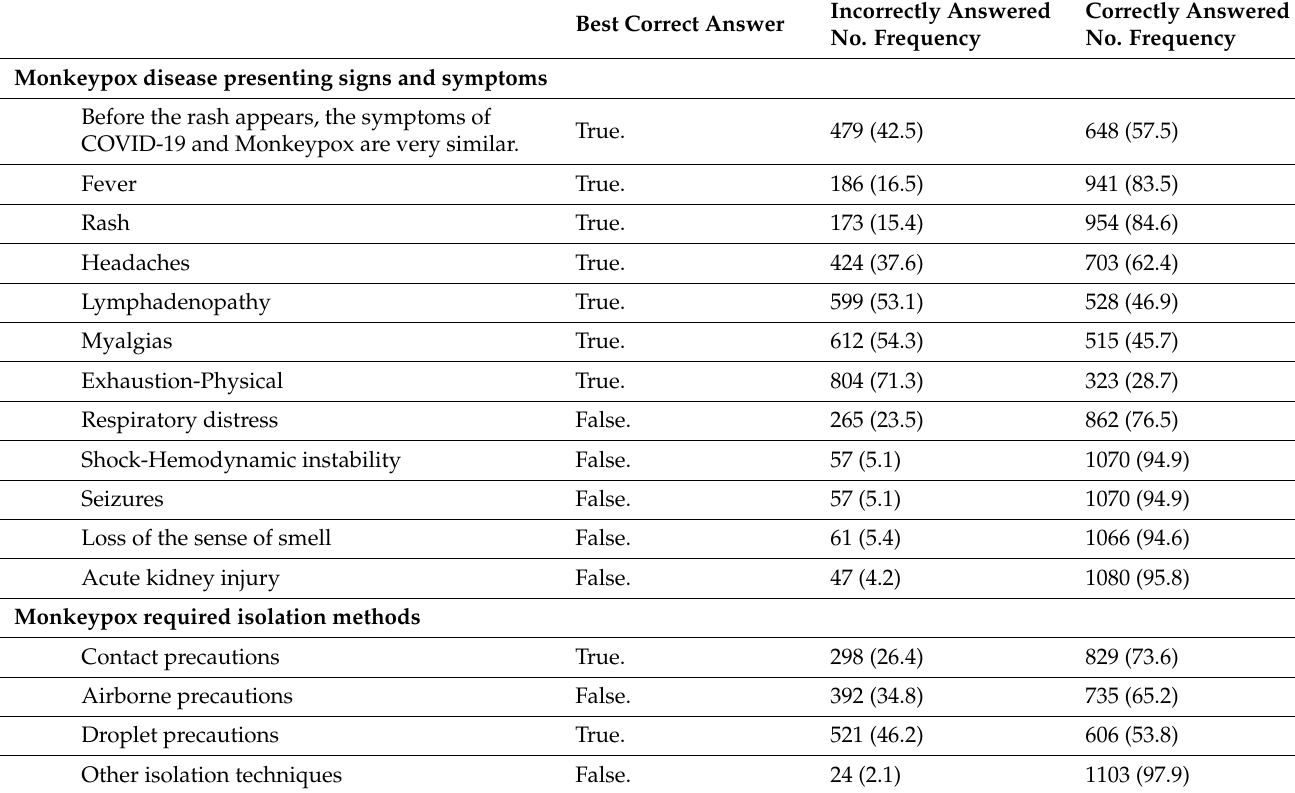
Table A2. Cont. Incorrectly Answered Correctly Answered Best Correct Answer No. Frequency No. Frequency Monkeypox disease presenting signs and symptoms Before the rash appears, the symptoms of COVID-19 and Monkeypox are very similar.